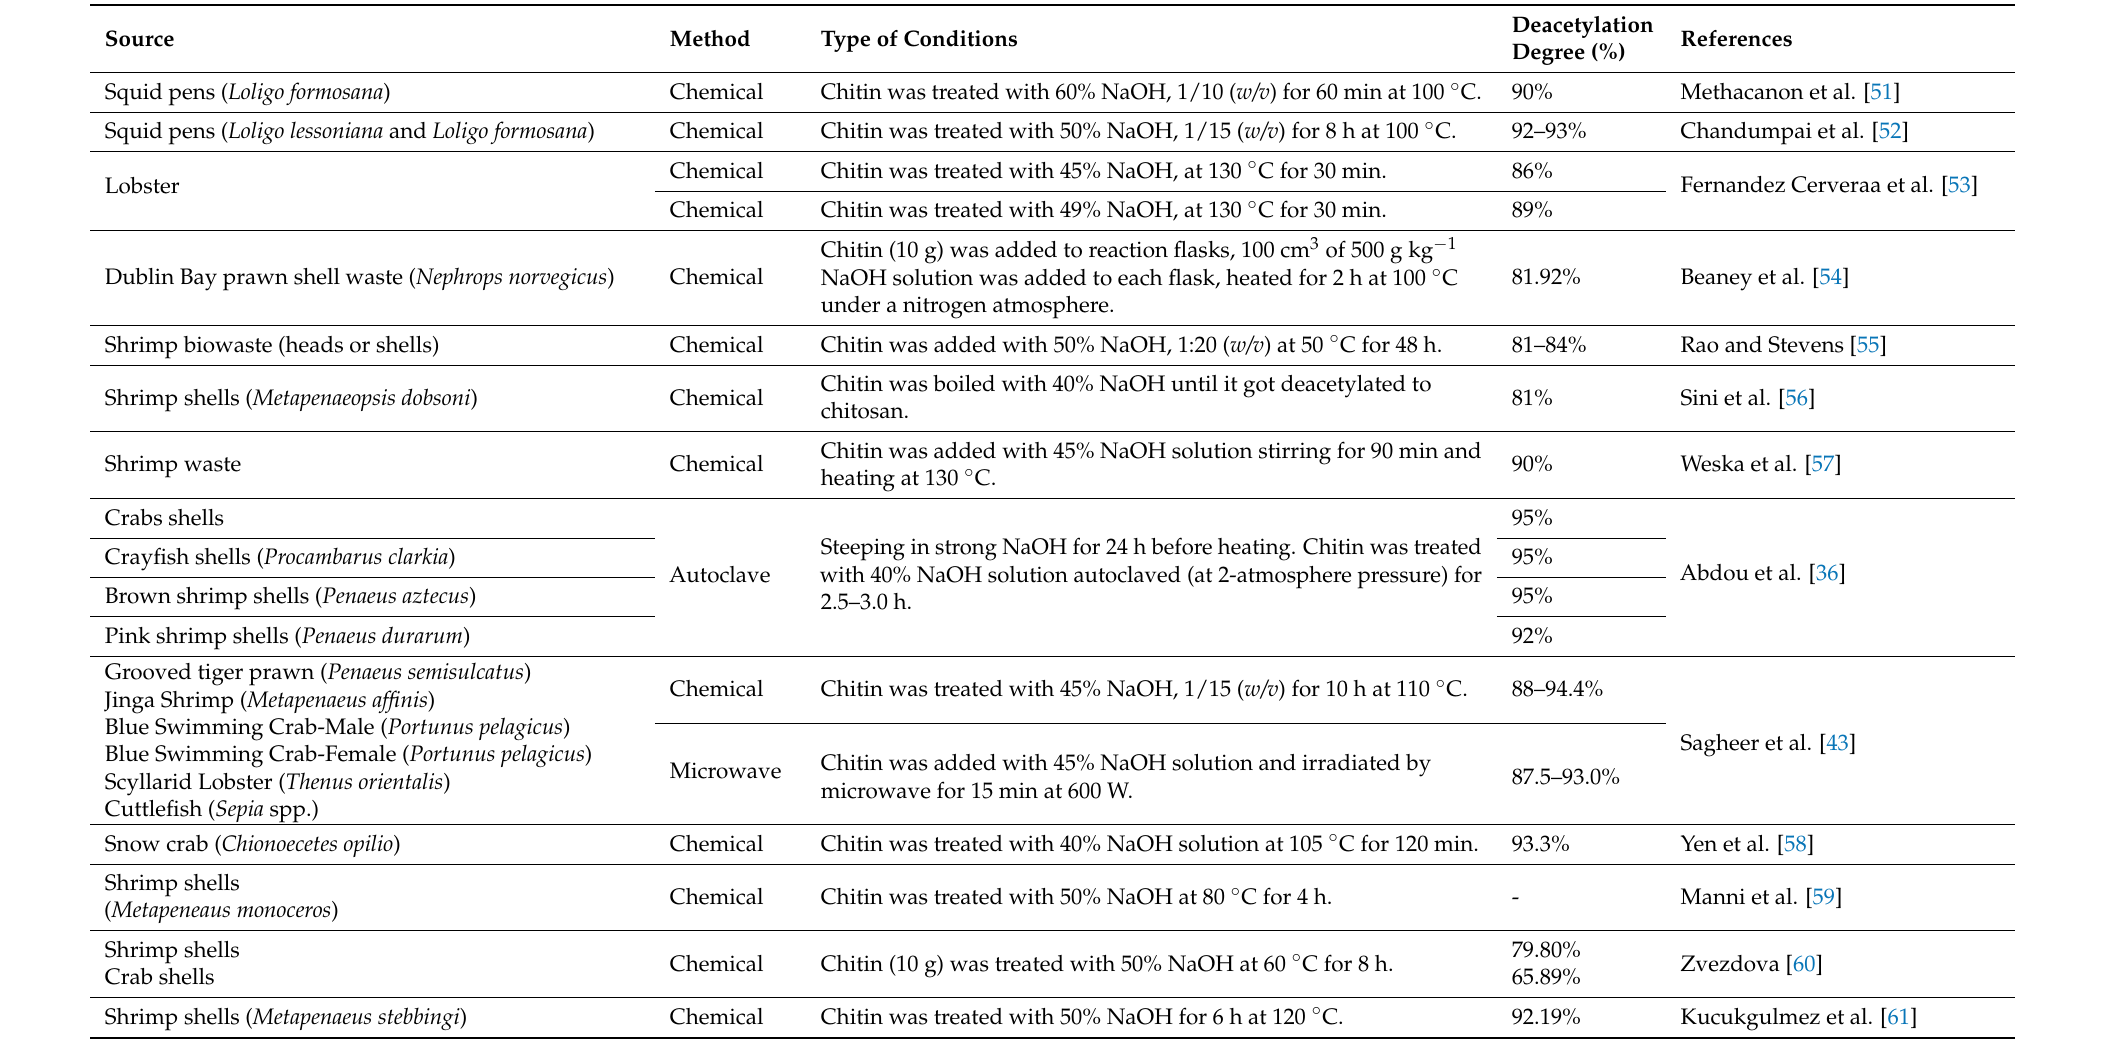
Table 1. Chitosan recovery methods currently in use and the varying conditions employed for